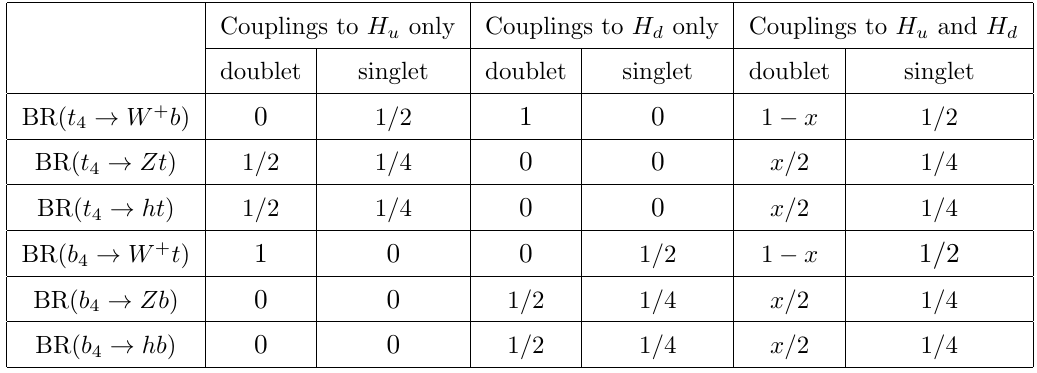
Table 3 . Vectorlike quark branching ratios in the Goldstone boson equivalence limit. x varies between 0 and